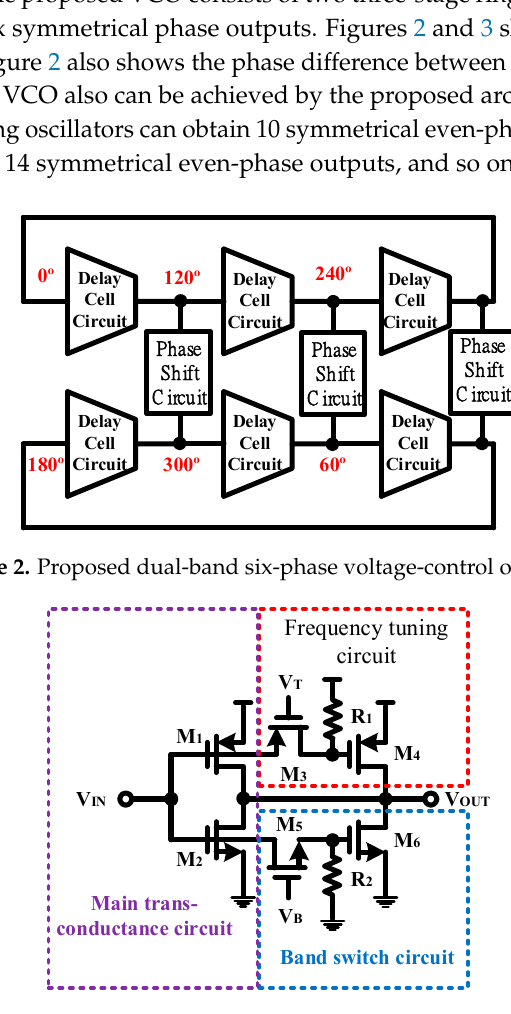
Figure 3. Proposed single-ended delay cell.